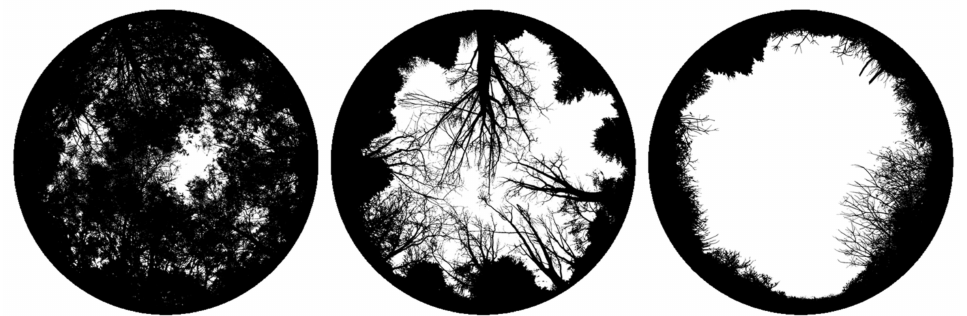
Figure 3. The hemispherical photo above represents observation